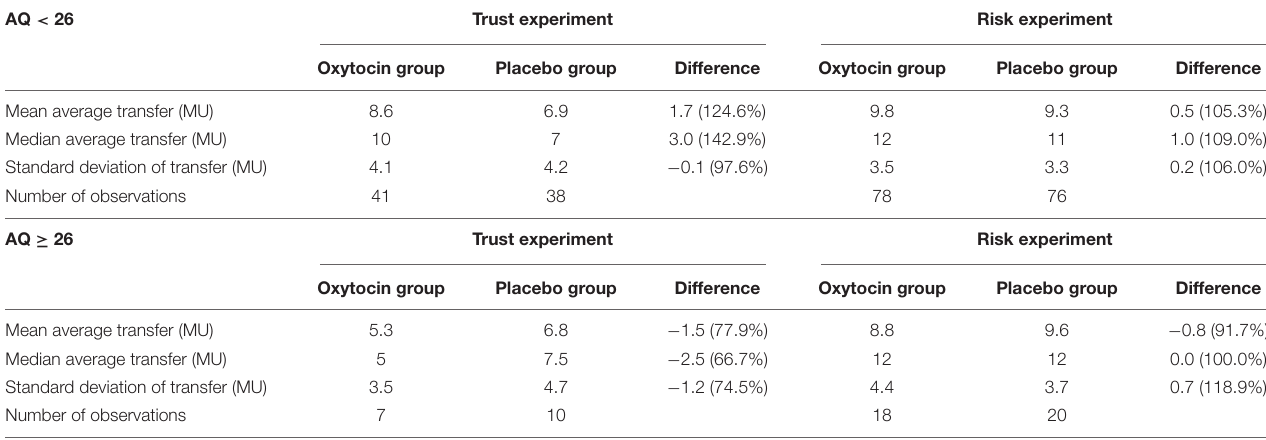
TABLE 2 | Transfer behavior of investors, stratified by autism quotient (AQ) score. AQ <